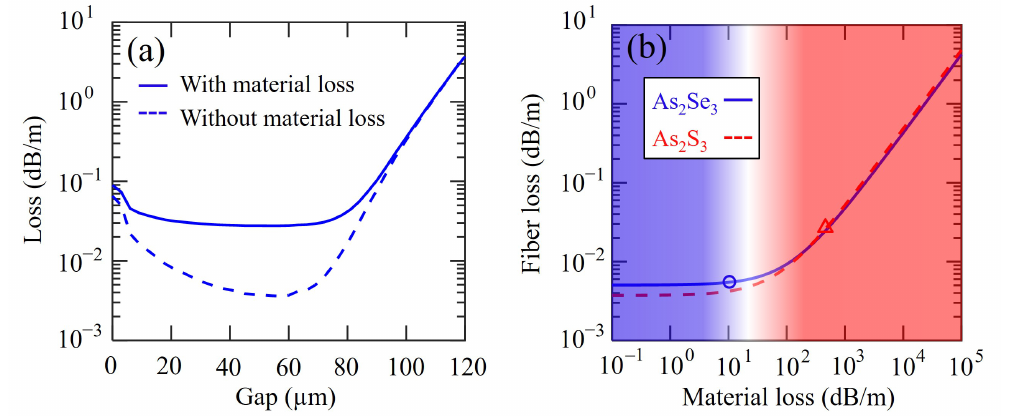
Figure 7. ( a ) Loss as a function of gap in fibers with and without material loss. ( b ) Fiber loss as a function of material loss in As 2 Se 3 chalcogenide glass fiber and As 2 S 3 chalcogenide glass fiber with six cladding tubes, a core diameter of 300 µ m, and a gap of 60 µ